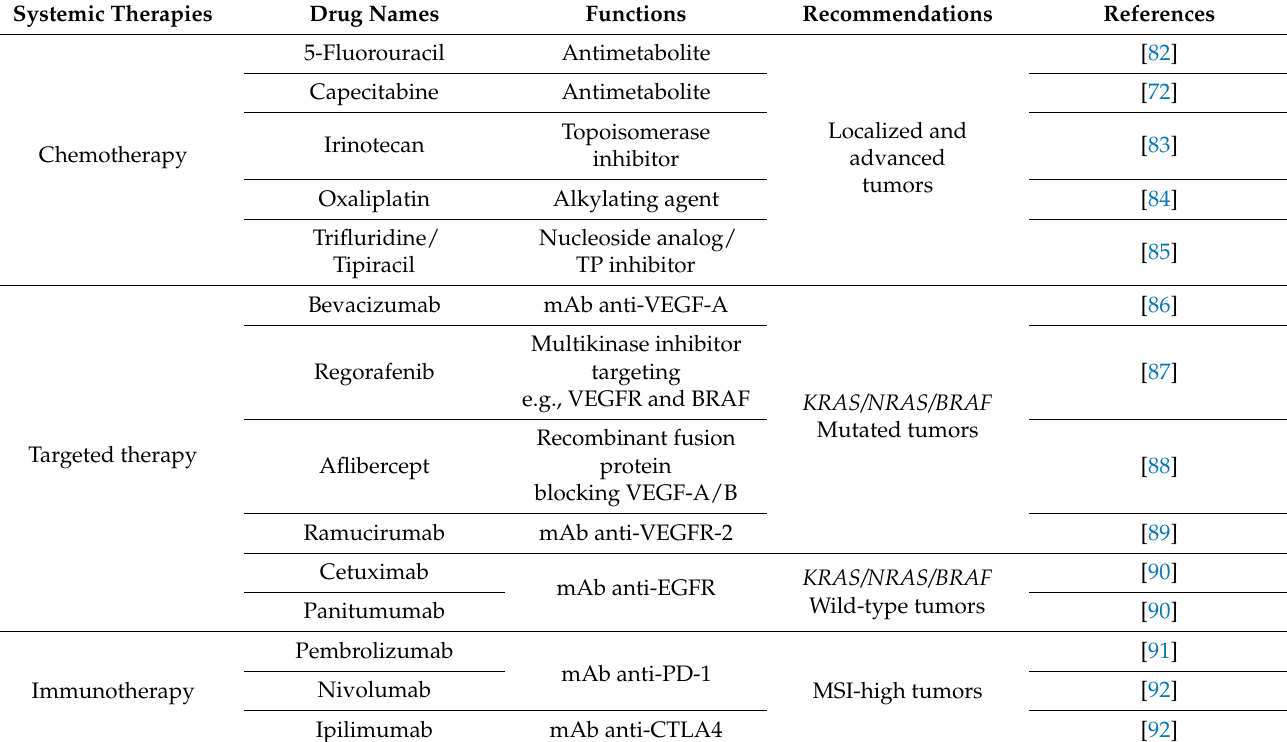
Table 4. Systemic therapies for localized and advanced colorectal cancer. Systemic